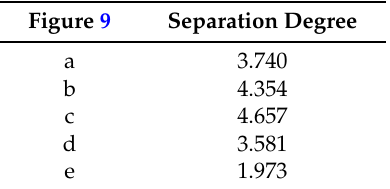
Table 1. The separation degree between the base metal and the groove region in Figure